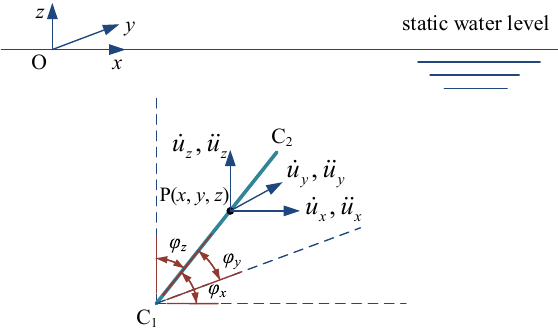
Figure 2. Structural vibration velocities and accelerations at point P( x , y , z ) on cylinder C 1 C 2 .